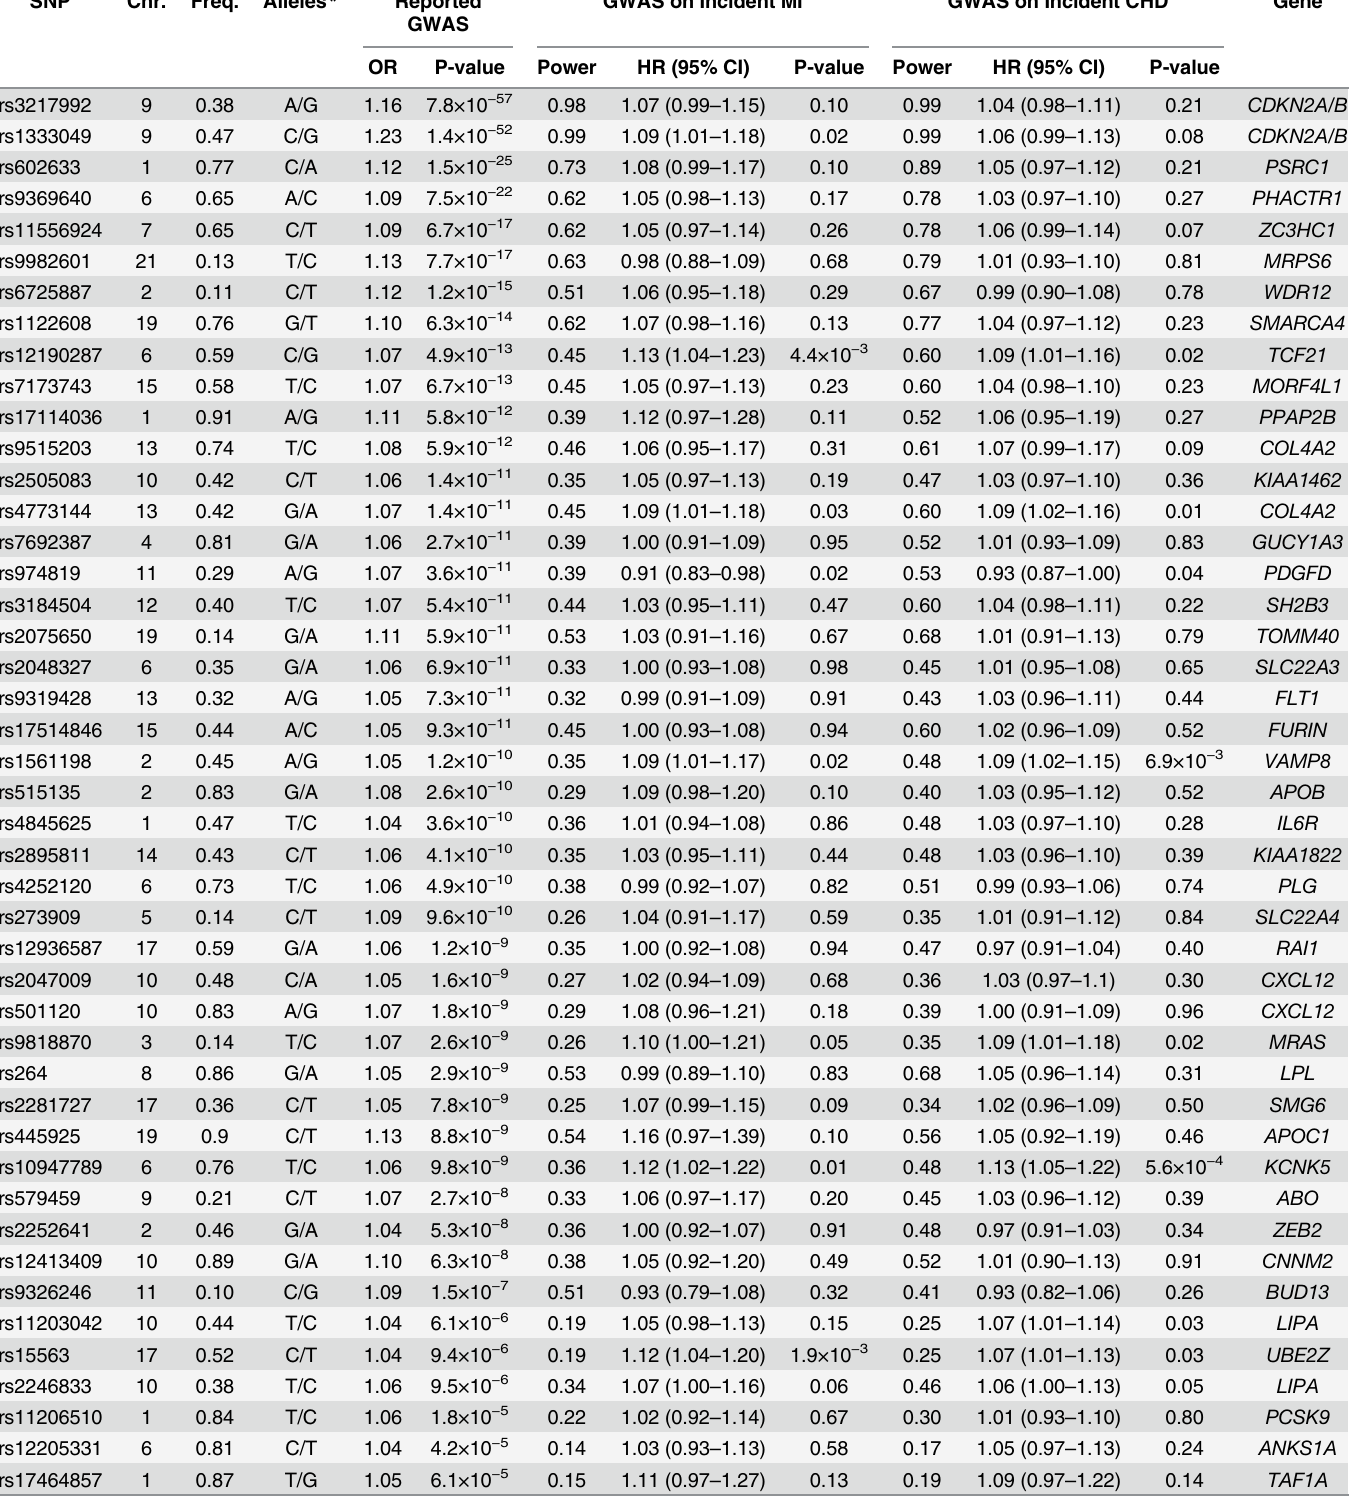
Table 4. Association of the known SNPs for coronary artery disease with incident MI and CHD in Stage I. SNP Chr. Freq. Alleles